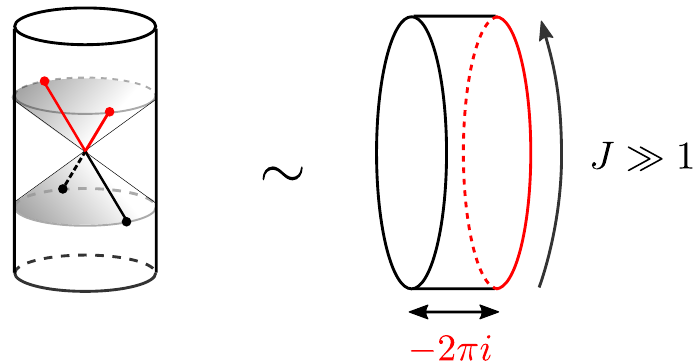
Figure 39 . The bulk-point limit and the cylinder partition function. The bulk-point limit corre- sponds to taking the length of the cylinder to be (cid:0) 2 (cid:25)i . This is similar to the situation studied in the context of the Loschmidt echo